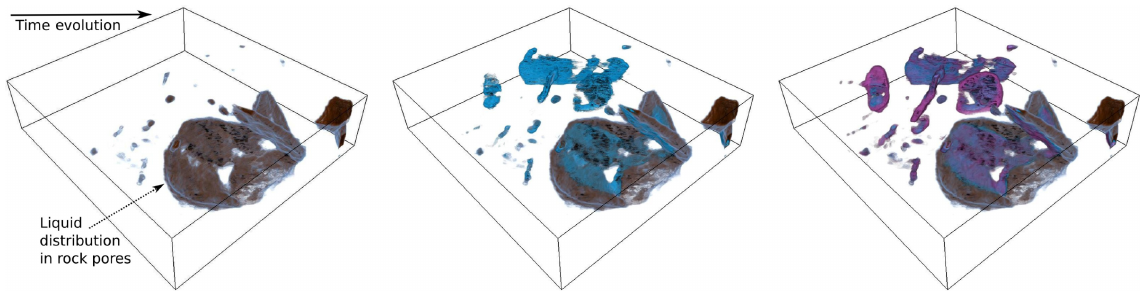
Figure 8. The fluid phase in the rock sample at three different times of the water ingress. Each volume is reconstructed from 60 projections using the CGLS–NLST method.